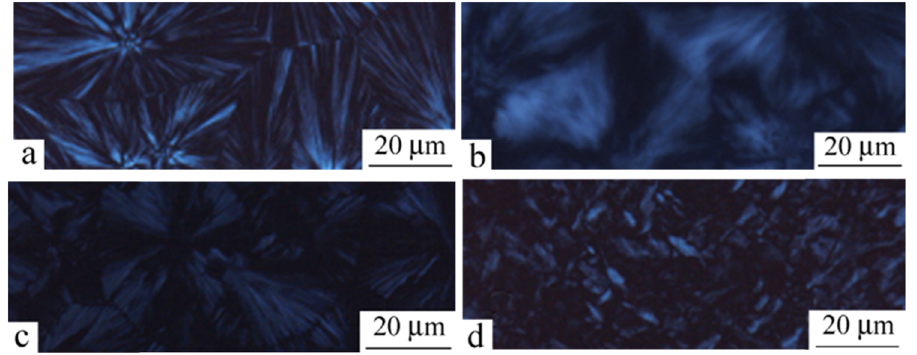
Figure 13: TEM diagrams of PP and SiO 2 /PP composites: ( a ) PP, ( b ) styrene - maleic anhydride copolymer ( PSM ) ( PSM ) , ( c ) PS - 1, and ( d ) PS - 4 [ 76 ] ; Copyright: 2015 with permission from